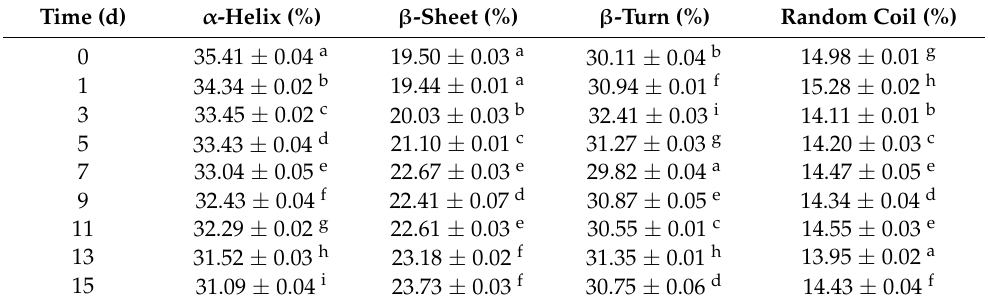
Table 3. Relative contents of secondary structures in Coregonus peled fillets stored at − 3 ◦ C for 15 days. Time